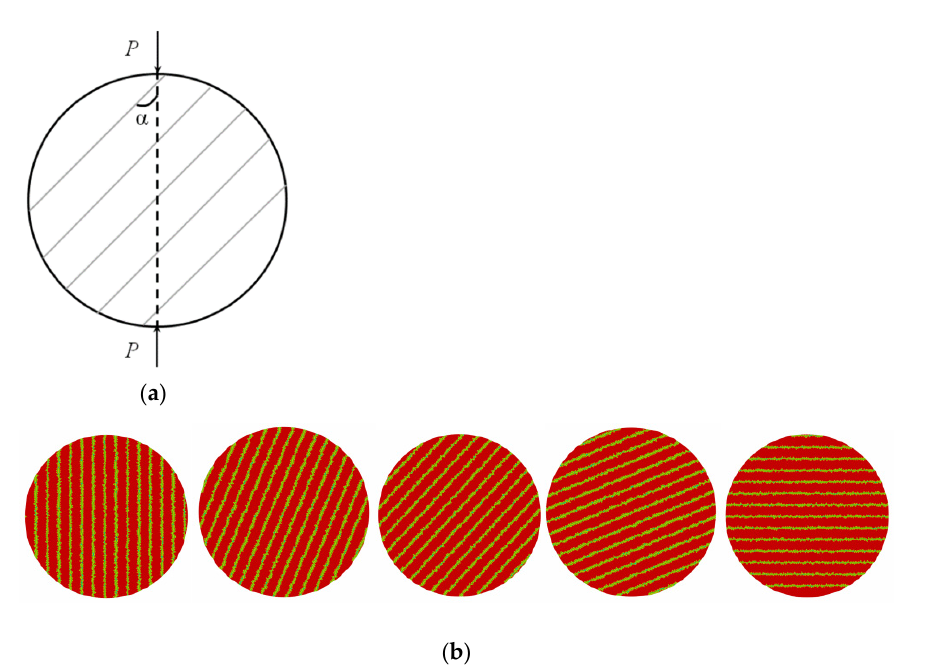
26 of 35 Figure 22. Flow chart of CDEM calculation steps.